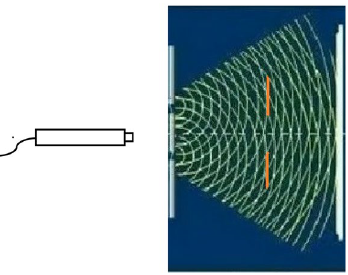
Figure 3. Interference of photon wave in the new quantum oscillation